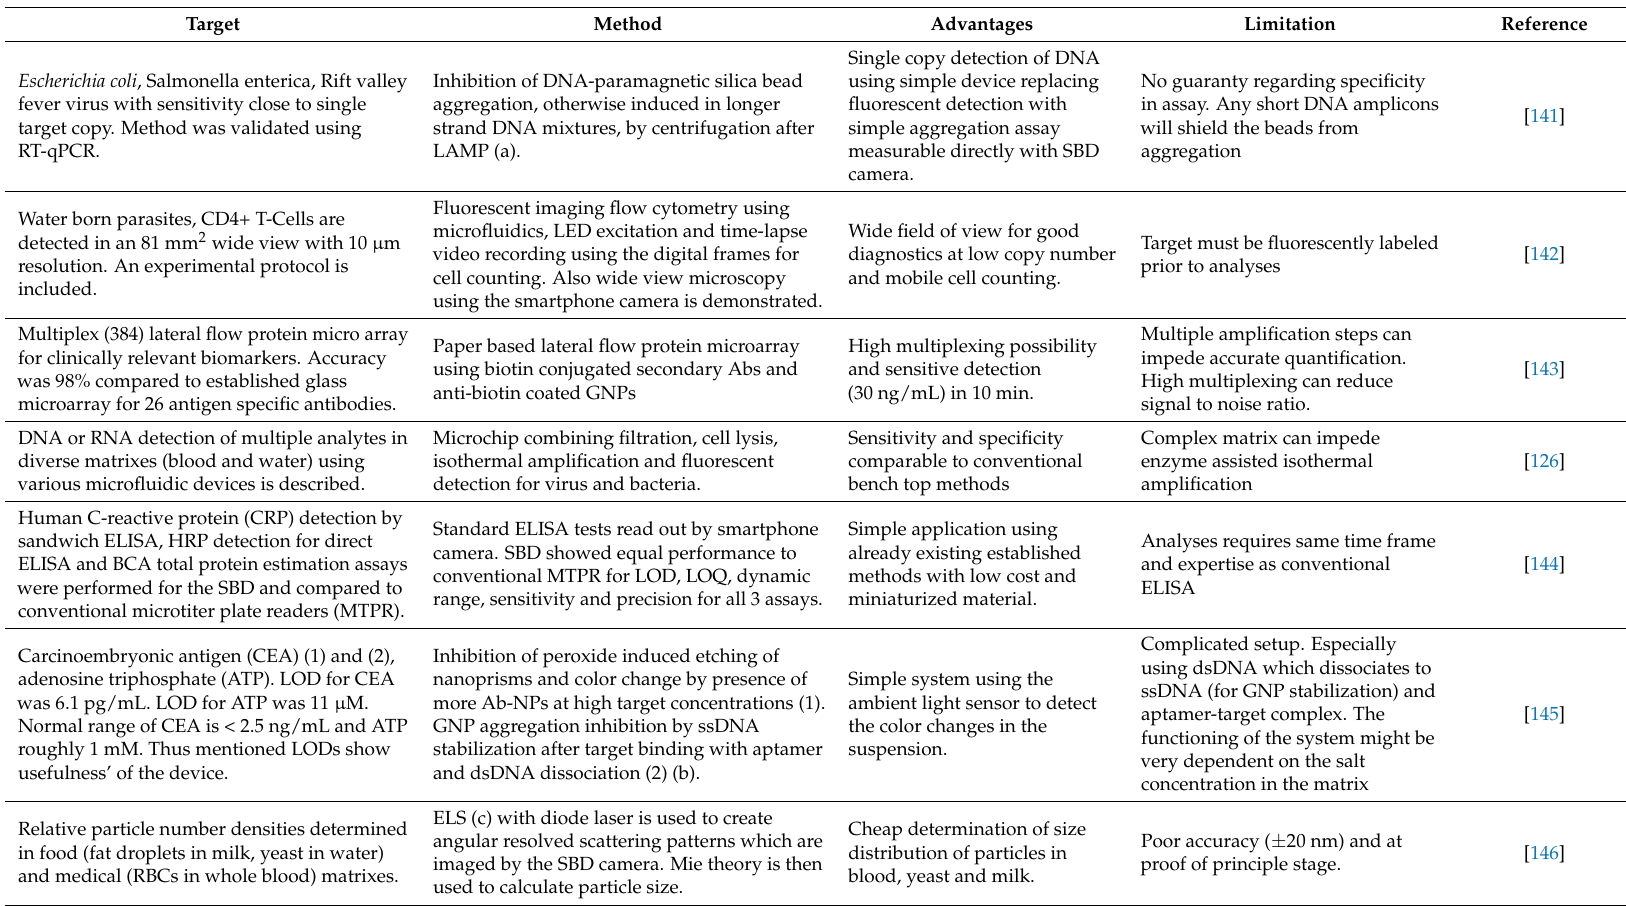
Table 2. A list of the SBDs that were not classified in any group since they have targets from various groups. Targets, detection methods, advantages and limitations of each SBD are